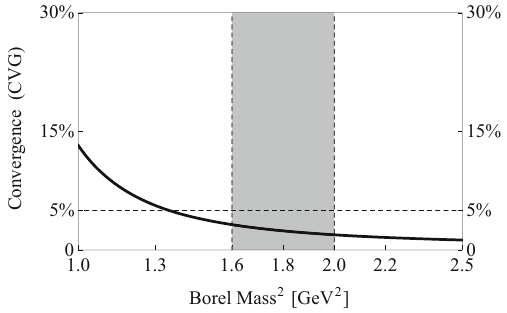
Fig. 2 The ratio CVG, defined in Eq. (21), as a function of the Borel mass M B . The curve is obtained by taking s 0 = 6 . 0 GeV